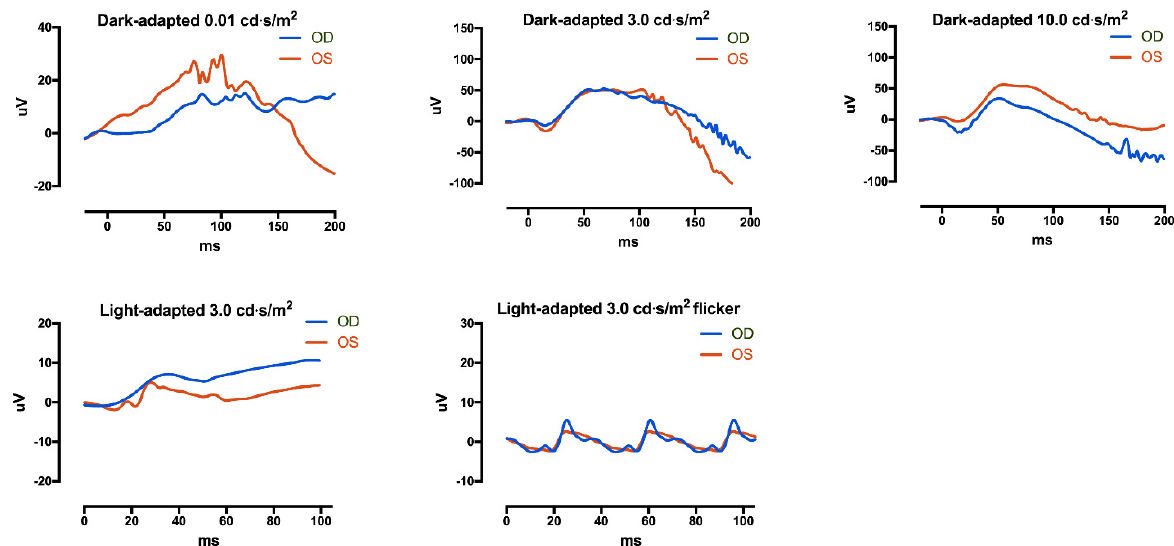
Figure 2. Electroretinography (ERG) was performed with skin electrodes. ( Top ) Dark-adapted 0.01 ERG, dark-adapted 3.0 ERG, and dark-adapted 10.0 ERG showed relatively normal waveforms, but the patient was very uncooperative during examinations. ( Bottom ) Light-adapted 3.0 ERG 3.0 flicker was obtained. Photopic ERG responses seemed to be reduced, but the result was inconclusive due to poor cooperation. The flash strength unit is cd·s/m 2 .